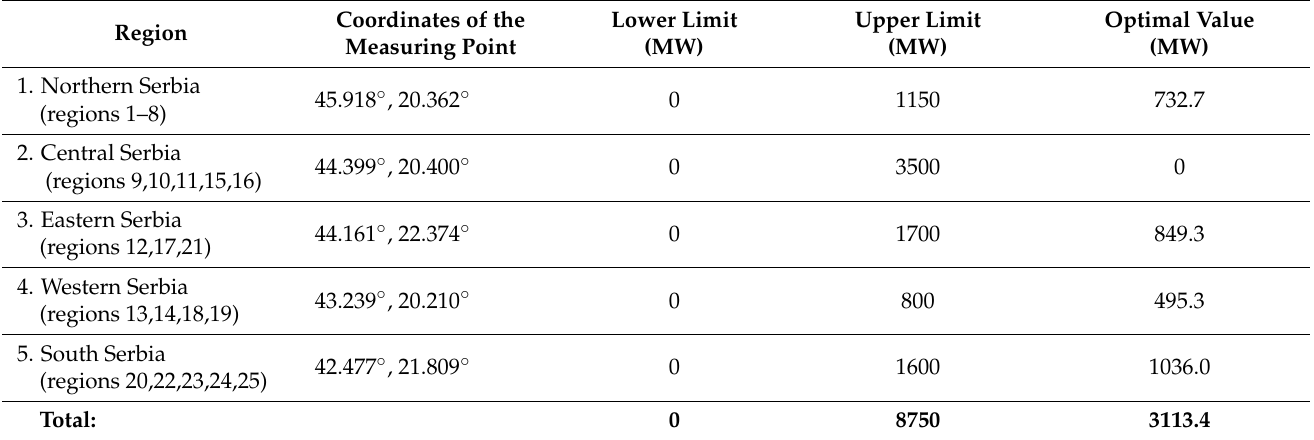
Table 2. Optimal capacities of utility scale PVPPs in regions with technically exploitable PV resource.